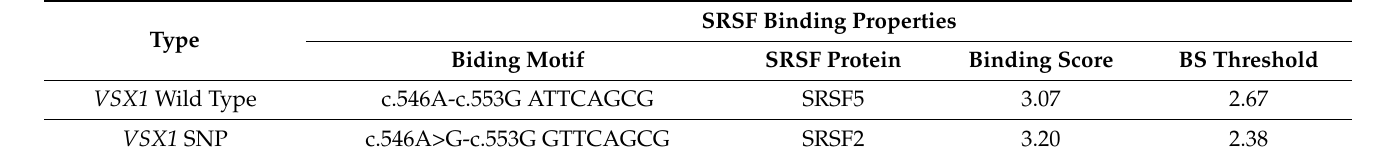
Table 3. Variation in ESE-SRSF protein binding properties between VSX1 Wild Type c.546A as com- pared to VSX1 SNP c.546A>G analyzed using the ESE finder.